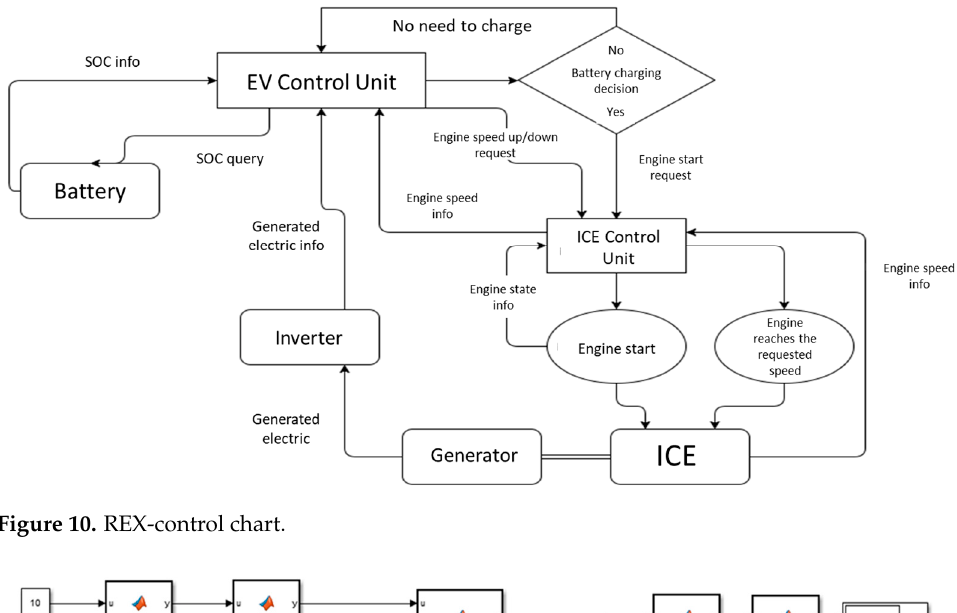
Figure 10. REX-control chart.